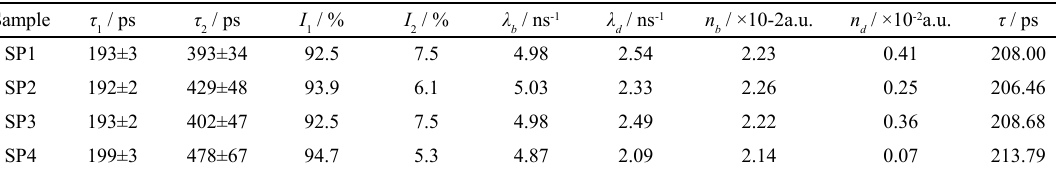
Table 2. The parameters of the positron annihilation lifetime spectra of the BTSN ceramics. Sample τ / ps 1